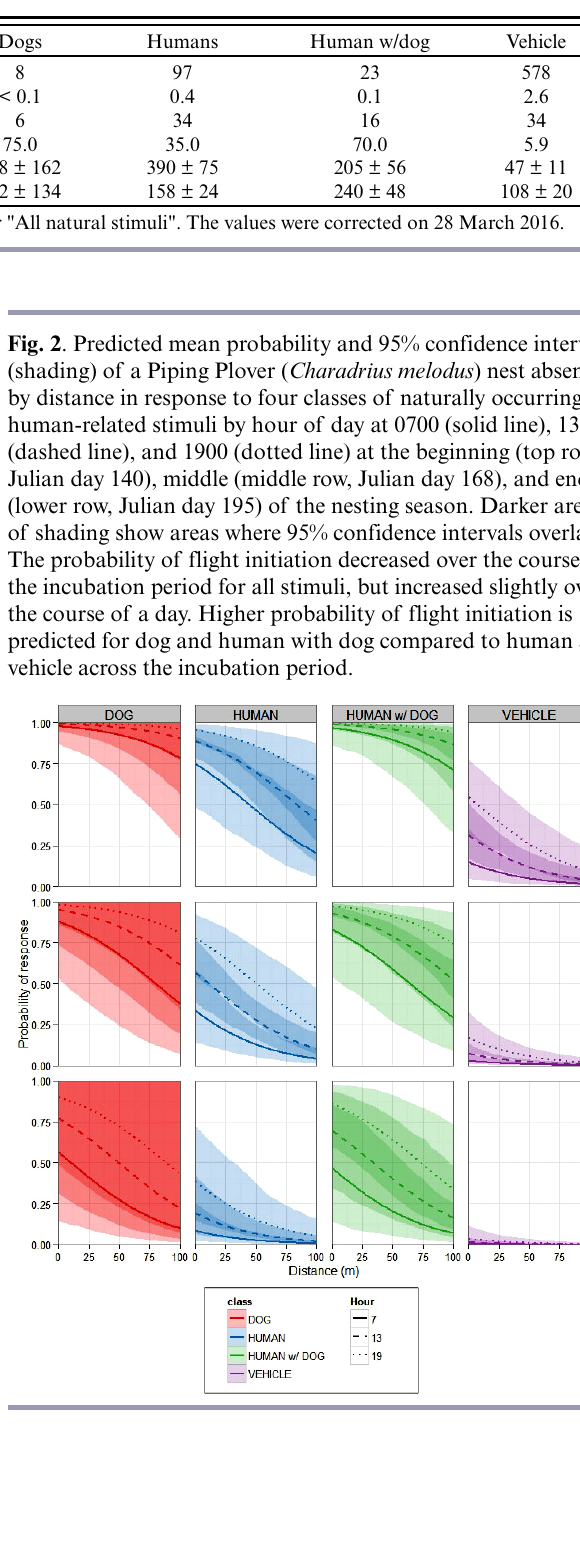
Table 1 . Summary of Piping Plover ( Charadrius melodus ) encounters with stimuli showing overall number, stimuli per hour, number, and percent of encounters eliciting a response, distance of response and nearest approach, stimulus encounter duration, and return times. Piping Plovers responded more frequently and at greater distances when dogs were present. Return times were greatest for dogs and human with dog.